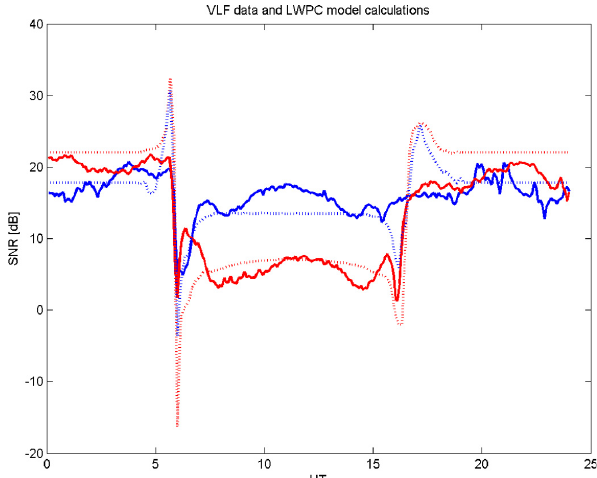
Fig. 9. VLF data and (cp. Fig. 1) and propagation modeling (dot- ted lines) with LWPC: radio signal amplitude with low (day over) absorption condition (blue, low day-night difference; 20% reduced collision frequency amplitude and 5% increased electron density amplitude between 65 and 85km height with respect to undisturbed electron density and collision frequency profiles (see text)) and high (day over) absorption condition (red curve, high day-night differ- ence; 30% increased collision frequency amplitude and 5% re- duced electron density amplitude between 65 and 85km